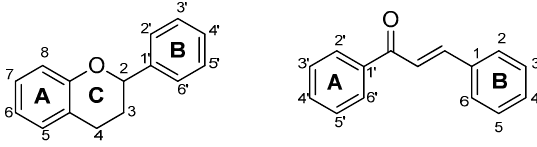
Figure 7. Flavonoids general scaffold with the carbons numbered.